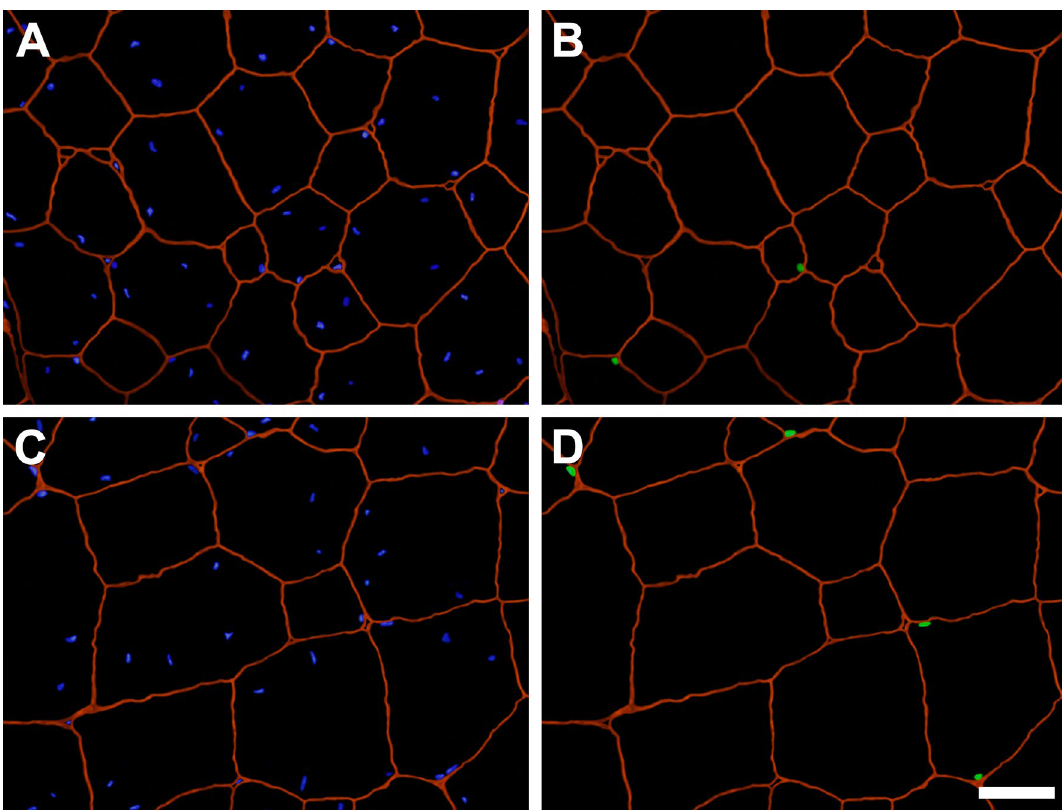
Figure 3. Immunofluorescent identification of satellite cell nuclei (SCN) in cross sections of pectoralis major muscles obtained from control and mesterolone-treated chickens. ( A ) and ( B ) represent a section obtained from a control bird. ( C ) and ( D ) represent a section obtained from a mesterolone-treated bird. ( A ) and ( C ) show all nuclei in blue (DAPI staining) and the basal laminae of muscle fibers in red (anti-laminin staining). ( B ) and ( D ) show SCN in green (anti-Pax7 labeling) and the basal laminae in red. As a unique histological feature of the chicken pectoralis, myonuclei are normally found deep within the fiber sarcoplasm 12 . Scale bar = 30